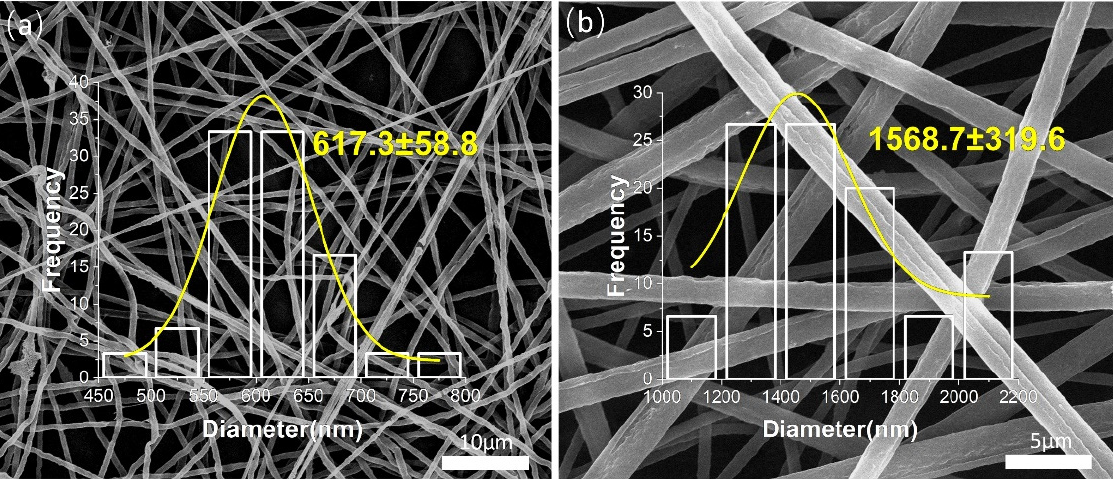
Figure 3. Characterization of F1 and F2 membrane by SEM: ( a ) F1—uniaxial fiber of PEO; ( b ) F2—coaxial fiber of PEO(core)/zein(sheath).